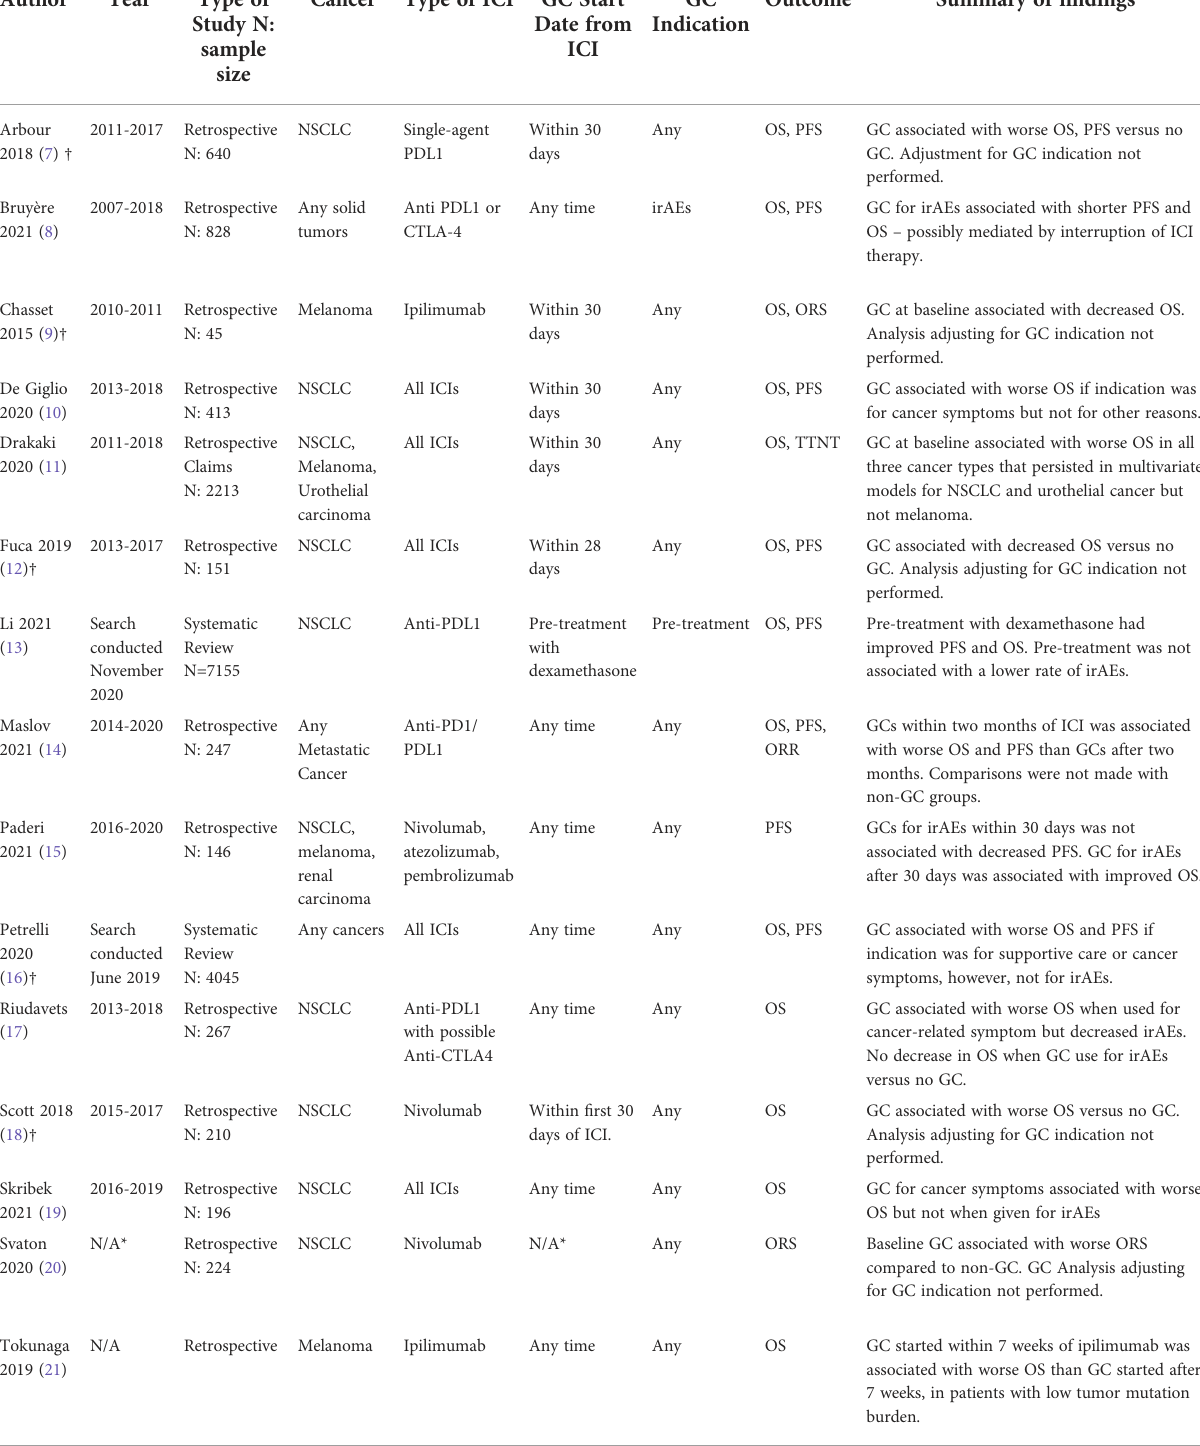
TABLE 1 Selected studies exploring the effects of glucocorticoids on cancer outcomes in the setting of immune checkpoint